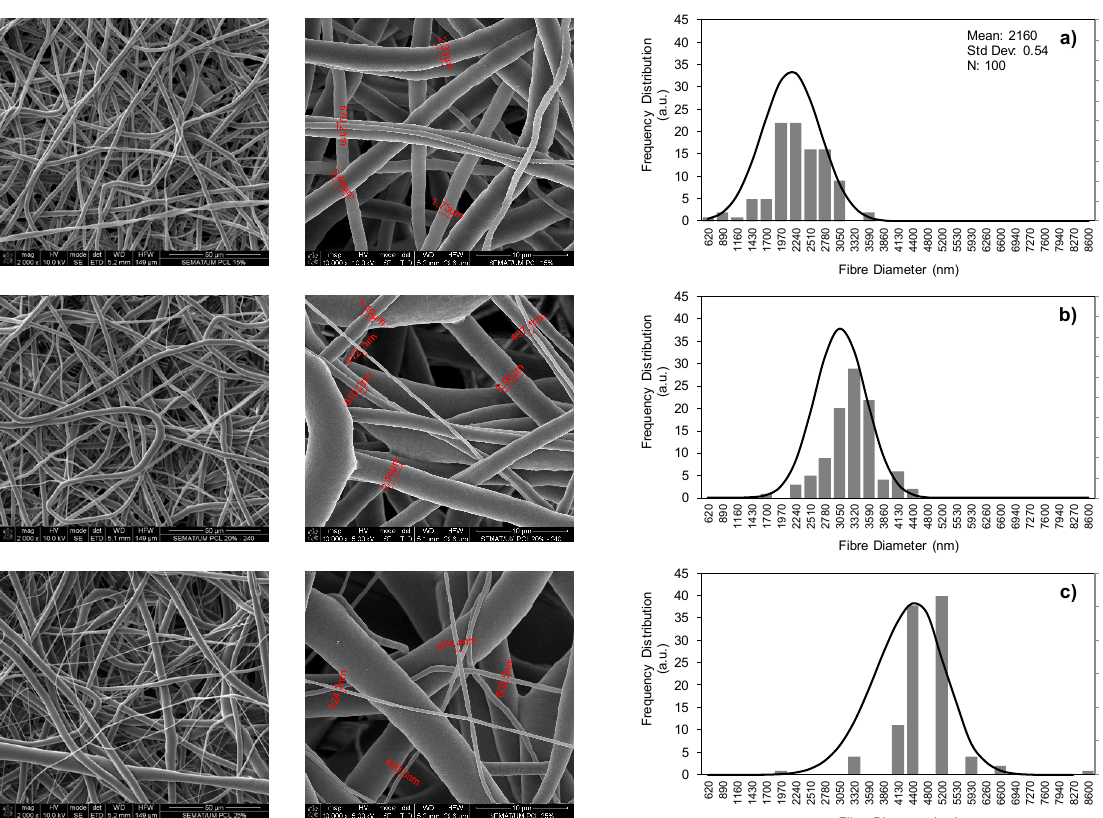
Figure 3. Field Emission Scanning Electron Microscopy (FESEM) images of the electrospun fibers produced using different PCL concentrations and their diameter distribution histograms: ( a ) 15%; ( b ) 20%; ( c ) 25% ( w/v ) in Chloroform (CHF)/Dimethylformamide (DMF) (4:1). From left to right: 2000× (50 µm); 10,000× (10 µm).